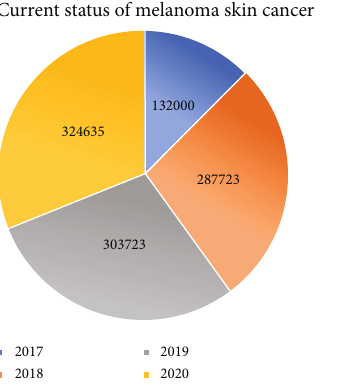
Figure 2: New cases of melanoma from 2017 to 2020 worldwide (Source: [1]).